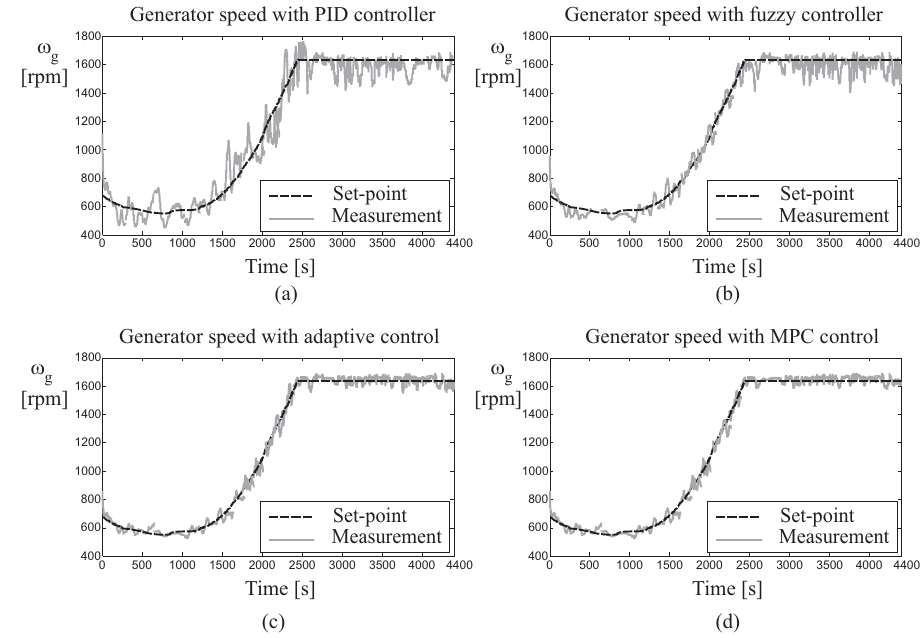
Figure 9. Wind turbine controlled output compensated by ( a ) the self-tuning PID regulator, ( b ) the fuzzy controller, ( c ) the adaptive regulator, and ( d ) the MPC approach with disturbance